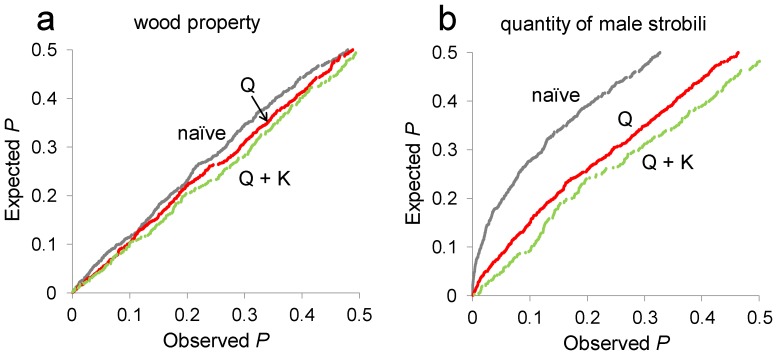
Comparison of models applied to C. japonica quantitative traits.Evaluation of the model type I error rates using random SNPs for wood property (a), quantity of male strobili (b). The cumulative distributions of observed P-values are presented for the naïve model, the Q model and the Q+K model.